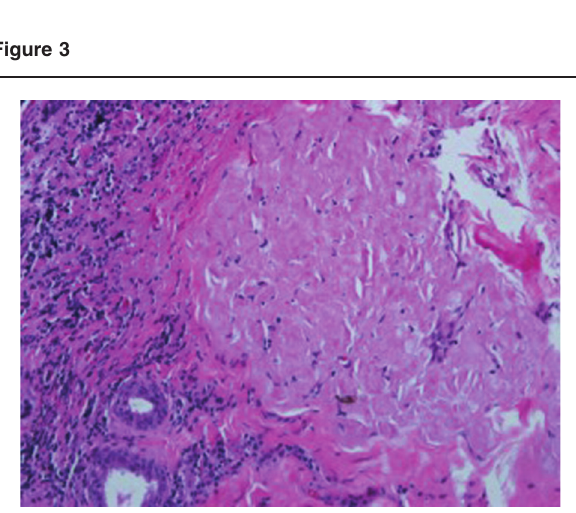
Apple – green birefringence with Congo red stain confirmed the diag- nosis of